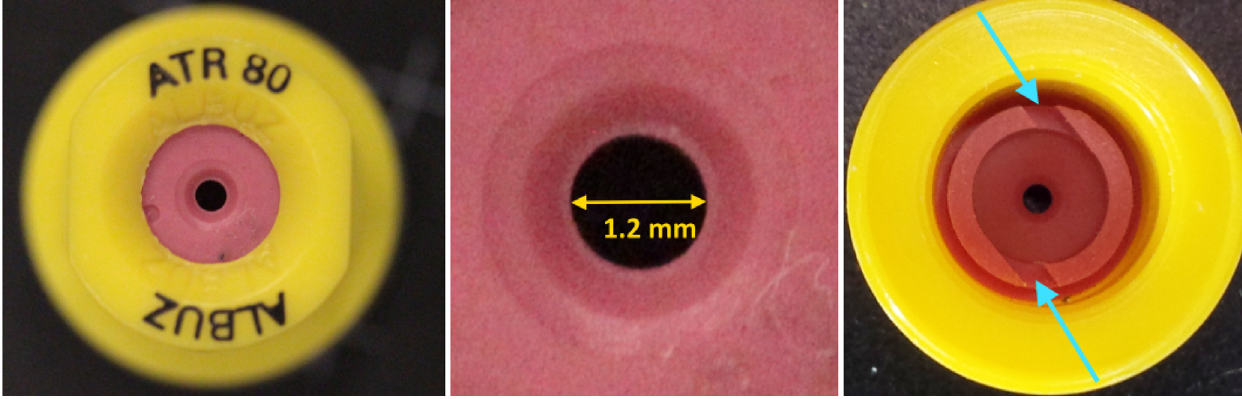
FIG. 13. A picture of the Albuz ATR 80 nozzle that produces a conical liquid sheet, seen from above (left-hand side) and from the inside (right-hand side). The inside of the nozzle has a cover, so that the fluid has to go through the two openings at the edge (blue arrows), forcing the liquid into a vortex flow, after which it leaves the nozzle through the